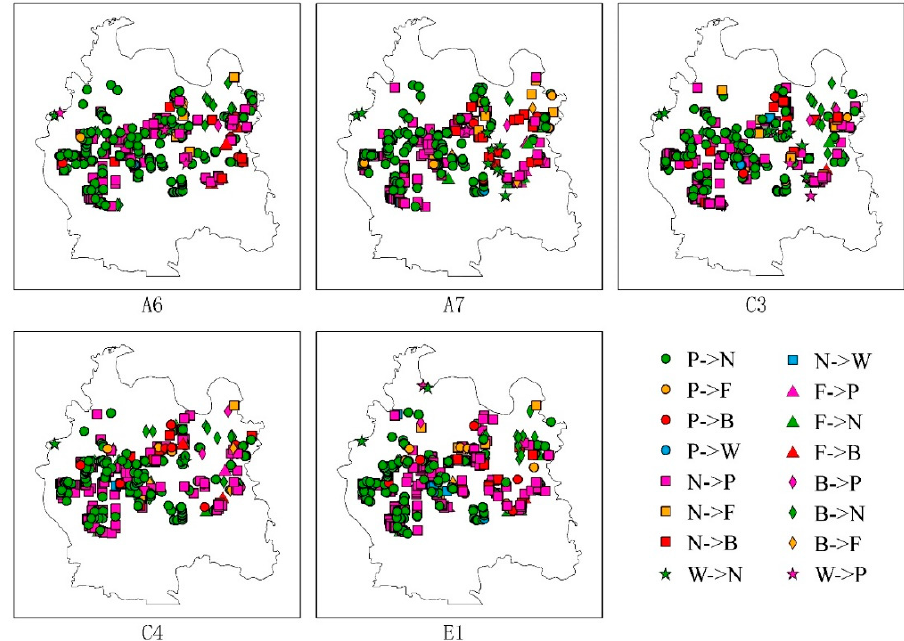
Figure 6. The spatial distribution of the classification error. P—Paddy rice, N—non-rice fields, F—forest, B—Built up area, W—water body. The arrowhead pointed from the true type to the classified type.